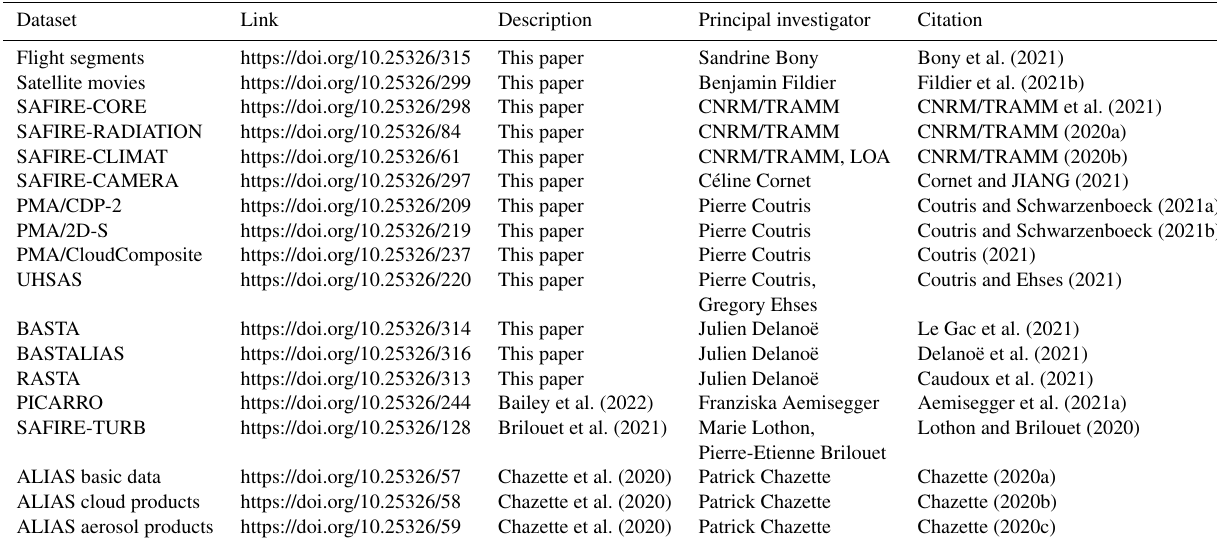
Table 11. List of ATR datasets derived from EUREC 4 A.